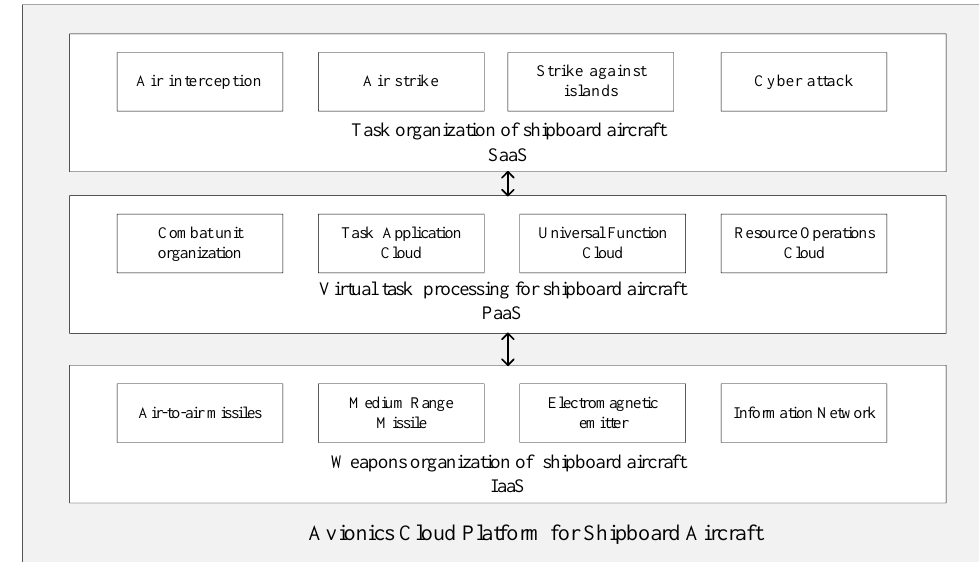
Figure 2. Layered view of Avionics Cloud IaaS, PaaS, and SaaS for shipboard aircraft.